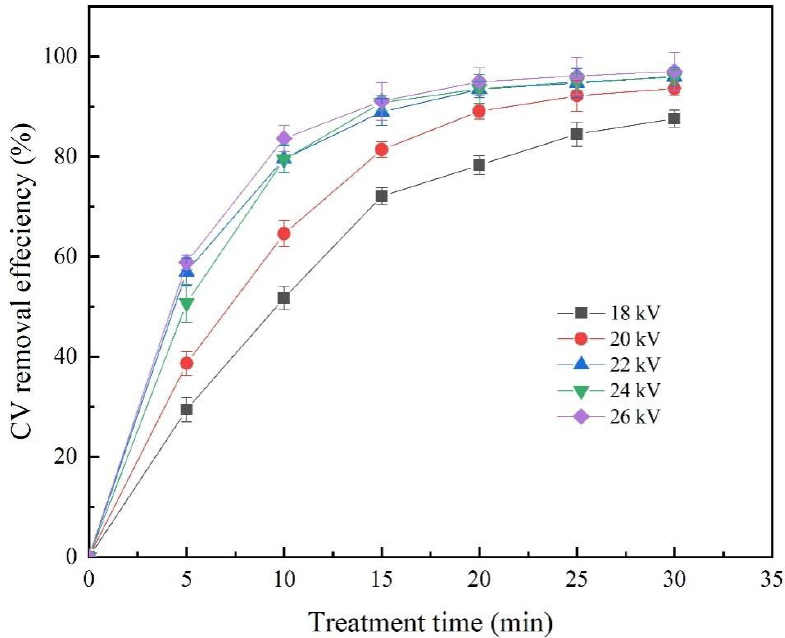
Figure 5. Effect of discharge voltage on the CV removal. (Initial CV concentration = 25 mg/L, frequency = 50 Hz, aeration O 2 = 3.0 L/min, red mud dosage = 2.0 g, conductivity = 26 μs/cm).